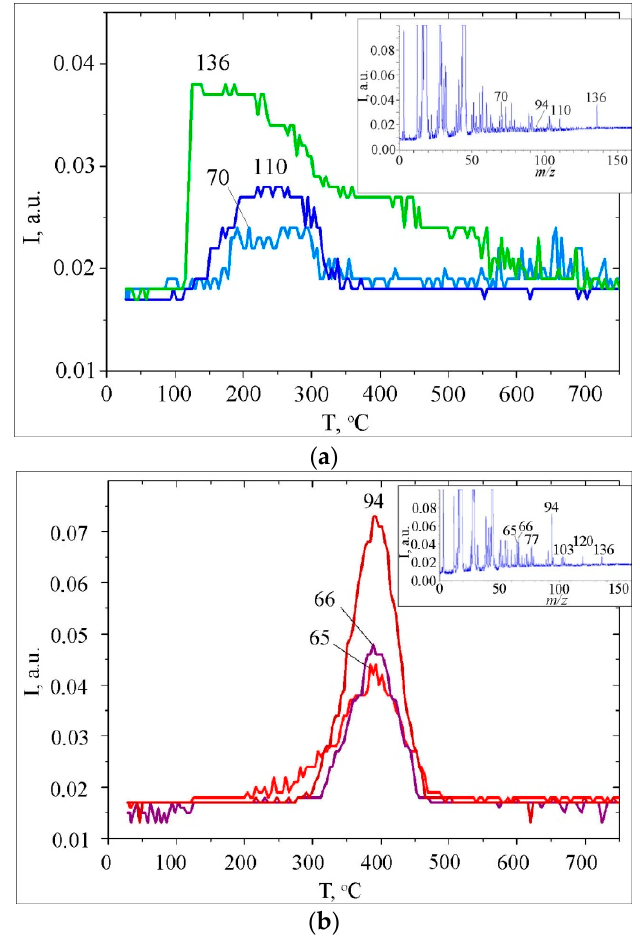
Figure 4. Thermal decomposition of CA/CeO 2 (0.6 mmol/g): ( a ) Mass spectra at 240 C and TPD curves for ions with m / z 136, 110, 70; ( b ) mass spectra at 380 °C and TPD curves for ions with m / z 94, 66, 65 °C ( b ).